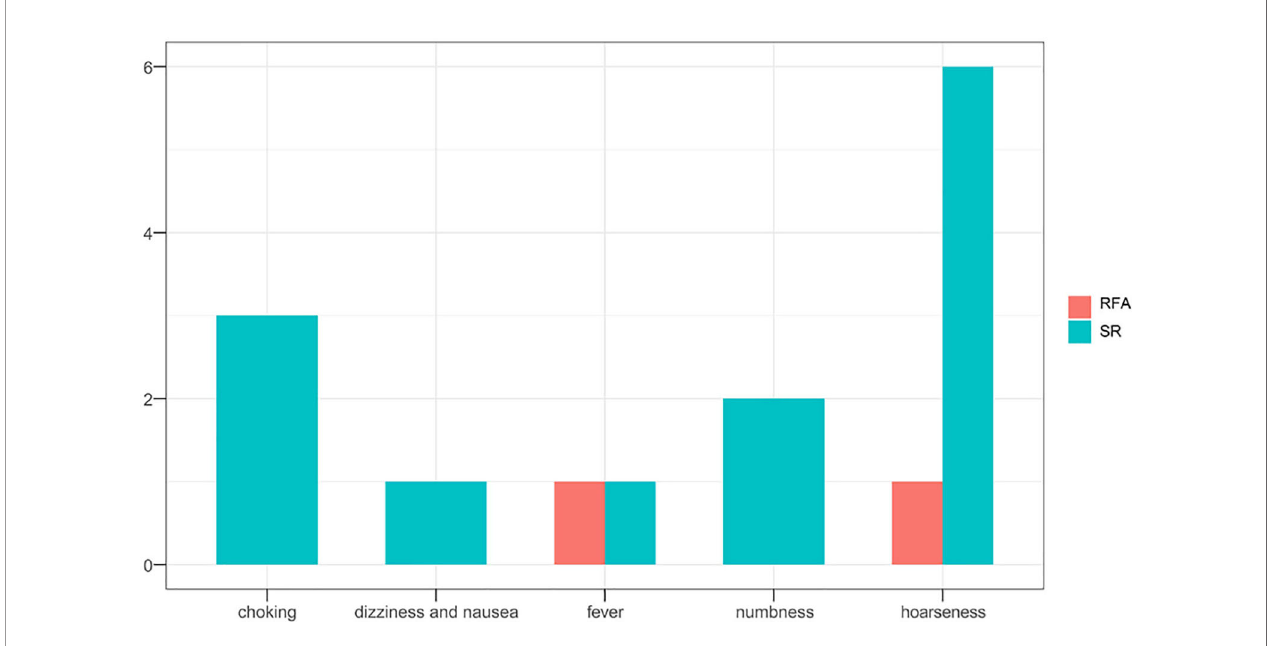
FIGURE 4 | Complication recurrence in both treatment groups.